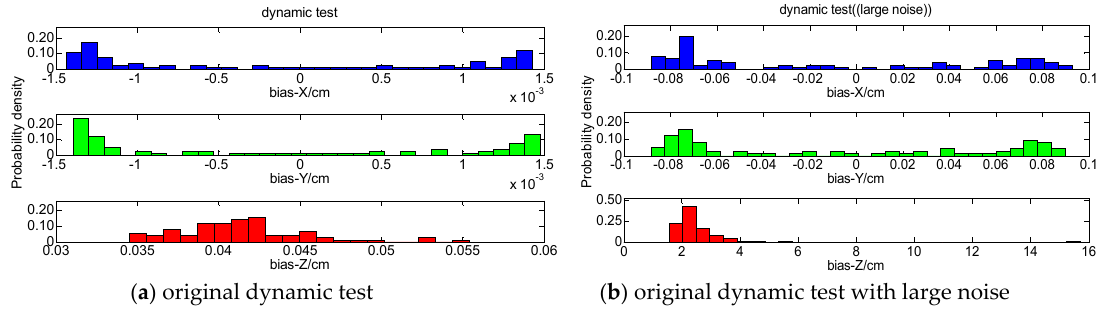
Figure 13. The frequency histograms of parameter estimator bias.